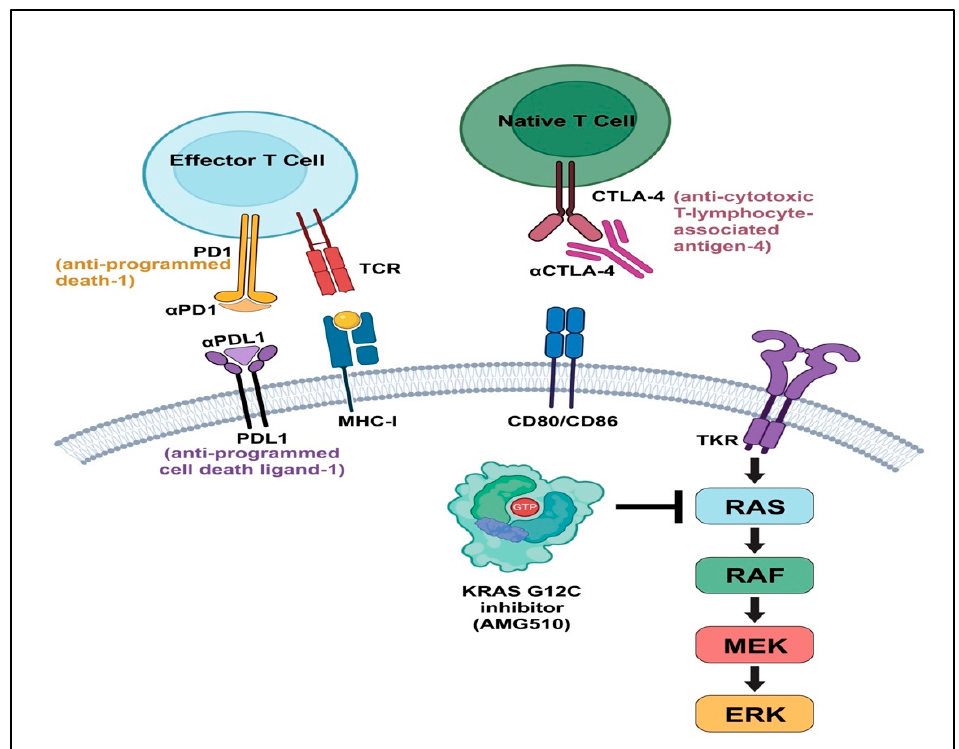
Figure 1. One mAb antitumor mechanism of action is elucidated by directly targeting the host’s immune cells. This schematic illustration demonstrates how PD-1/PDL1 binds and blocks the effector T cell surface receptor that is responsible for immune checkpoint signaling. This halts tumor growth and results in an antitumor effect. PD1: anti-programmed death-1, PDL1: anti-programmed cell death ligand-1, TCR: T cell receptor, MHC-1: major histocompatibility complex-1, CTLA-4: anti-cytotoxic T-lymphocyte-associated antigen-4.